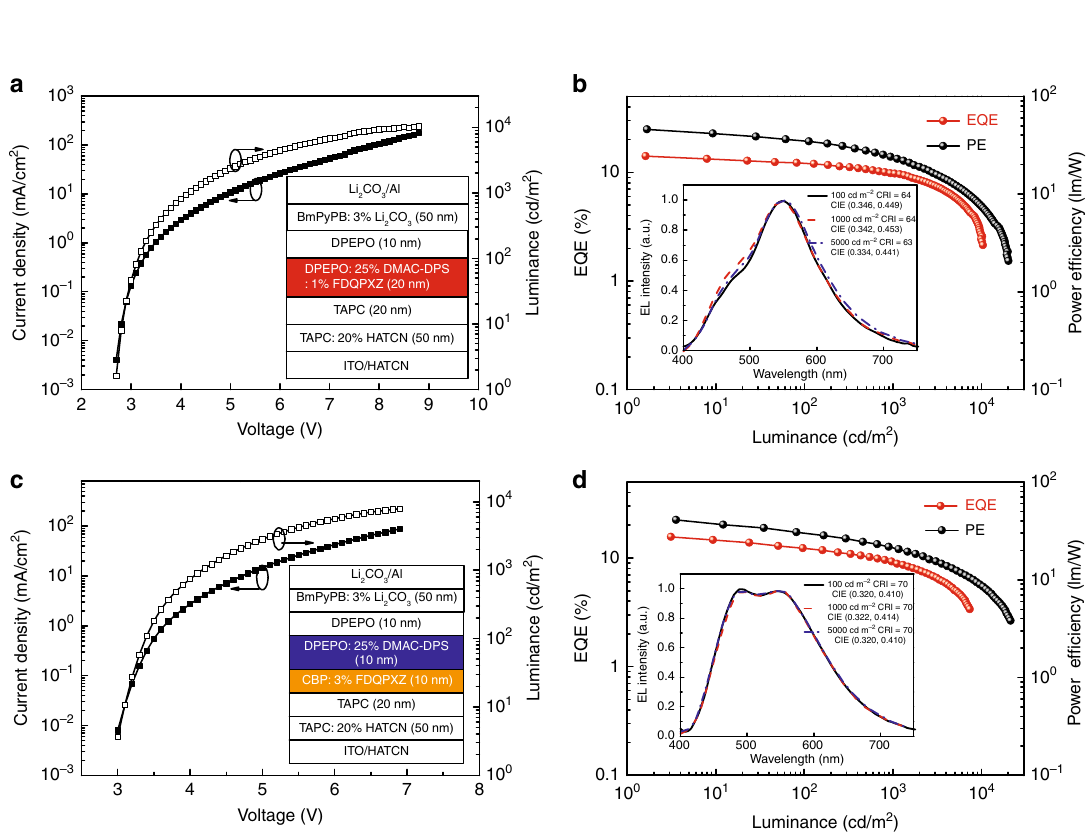
Fig. 3 Electroluminescence performance of reference devices . a Current density – voltage – luminance ( J – V – L ) characteristics of the reference white organic light-emitting diodes (WOLEDs) with the single-emissive layer. The inset illustrates the detailed device structure of the optimized reference fl uorescent WOLEDs. b External quantum ef fi ciency (EQE) and power ef fi ciency (PE)-luminance characteristics of the fl uorescent WOLEDs. Inset exhibits the normalized electroluminescence spectra at the different luminance of 100, 1000, and 5000 cd/m 2 , and the respective Commission Internationale de L ’ Eclairage (CIE) and color rendering index (CRI). c J – V – L characteristics of the reference WOLED with the double-emissive layer. The inset illustrates the detailed device structure of the optimized reference fl uorescent WOLEDs. d EQE and PE-luminance characteristics of the fl uorescent WOLEDs. Inset exhibits the normalized electroluminescence spectra at different luminance, and the respective CIE and